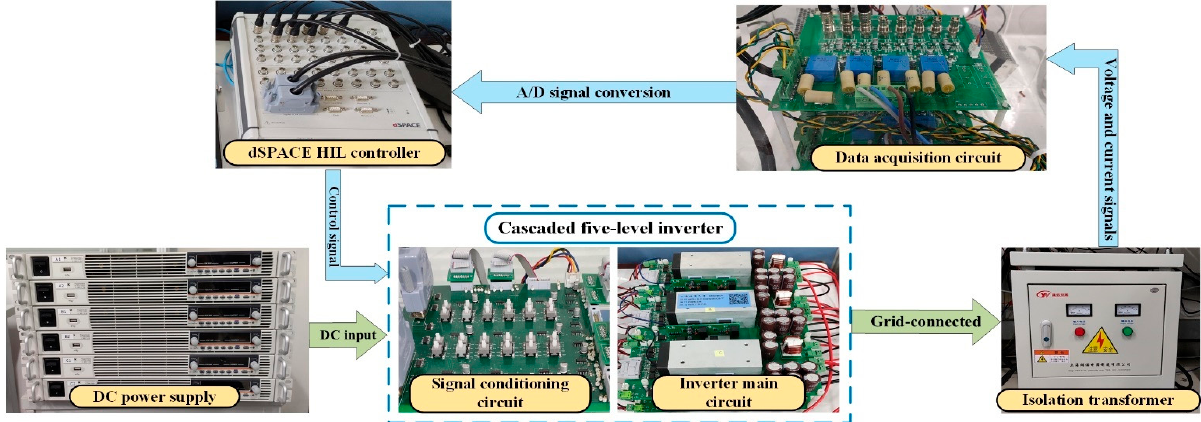
Figure 6. Grid-connected inverter experimental platform.